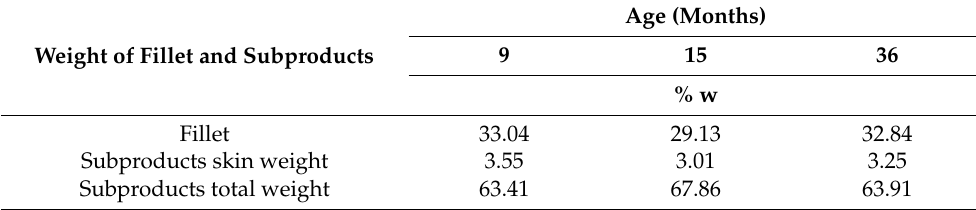
Table 2. Collagen yield of tilapia skin acid-soluble collagen (ASC) and pepsin-soluble collagen (PSC) of the red, gray, and F1 lineages, 9-months old ( p > 0.05).